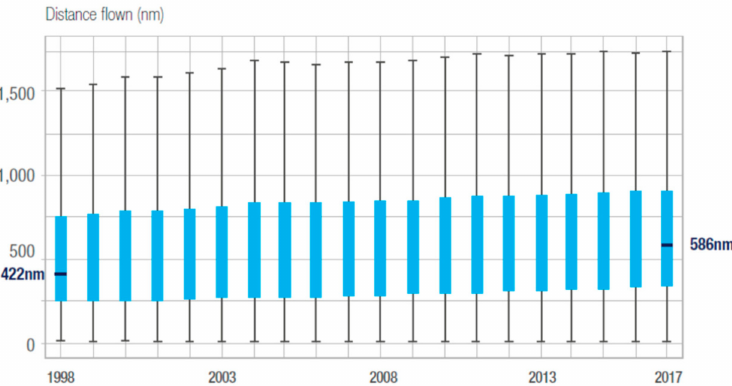
Figure 1. Distribution of single-aisle aircraft seats and ranges over the years. Reprinted from ref. [5].